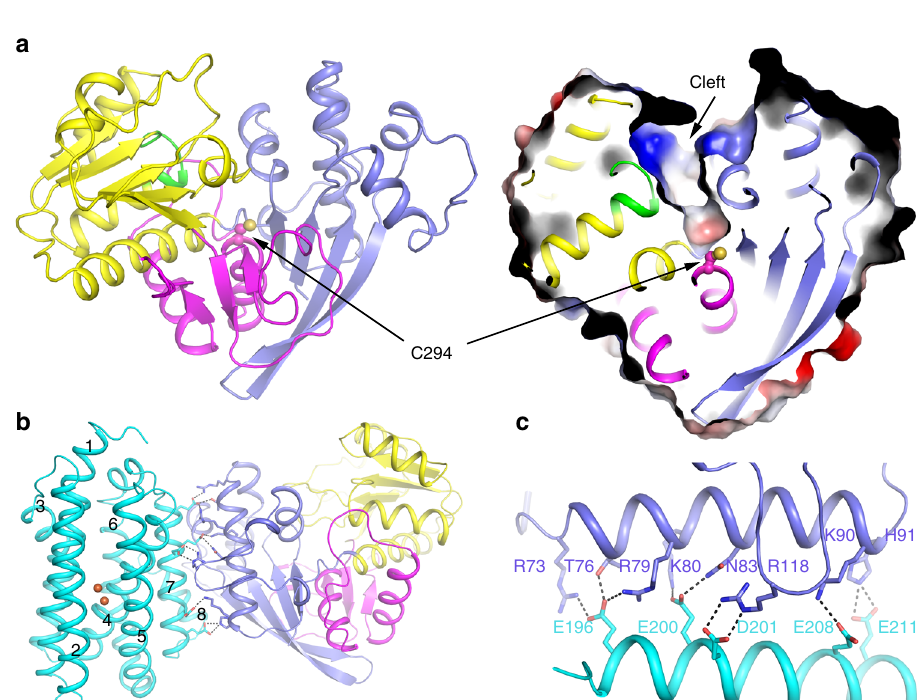
Fig. 1 Structures of AAR and AAR – ADO complex. a Cartoon (left) and surface (right) representation of AAR apo structure. NTD, mid-domain, and CTD of AAR are shown in slate, yellow and magenta, respectively. The dinucleotide recognition loop in the mid-domain is highlighted in green. The key residue C294 is shown in stick-ball mode and labeled. The cleft above the residue C294 was indicated by an arrow in the right panel. b Cartoon representation of AAR – ADO complex structure (shown by AAR NADPH – ADO structure). NTD, mid-domain, and CTD of AAR are shown in slate, yellow and magenta, respectively. ADO is shown in cyan and the eight helices are labeled as 1 – 8. The two iron atoms in ADO are shown in orange spheres. The residues involved in the intermolecular interaction are shown in sticks. The salt bridges and hydrogen bonds are shown by black dashed lines. The bound ligands are omitted for clarity. c Details of the intermolecular interaction between AAR and ADO. For clarity, only fragments of AAR (R73 – H91 and L114 – L122) and ADO (helix 7) are shown. The residues involved in the intermolecular interactions are shown in sticks and